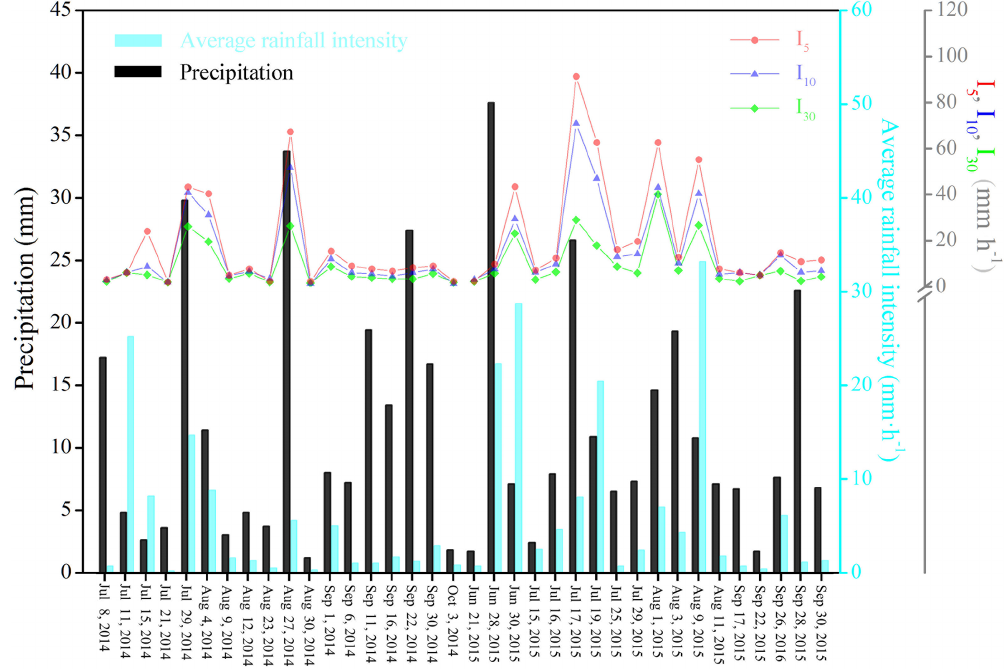
Figure 3. Meteorological characteristics of rainfall events for stemflow measurements during the 2014 and 2015 rainy seasons.